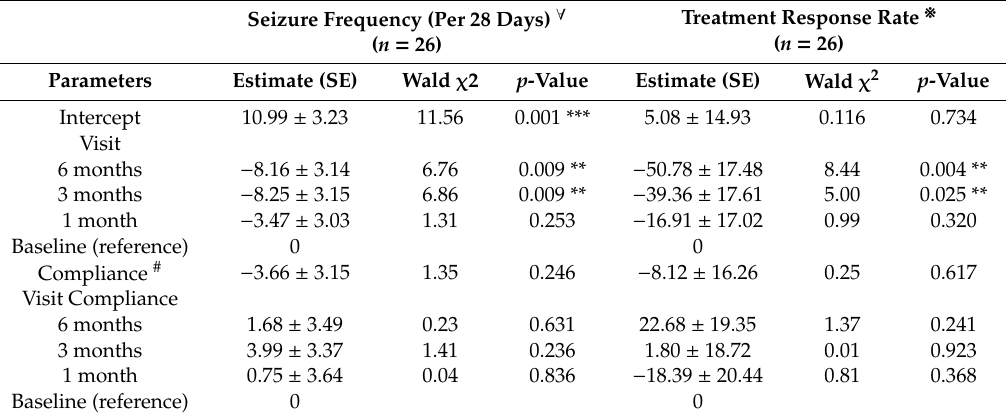
Table 5. Generalized estimating equations analysis of seizure frequency and treatment response rate after 6 months of multivitamin supplementation in the patients with intractable focal epilepsy (adjusted compliance).